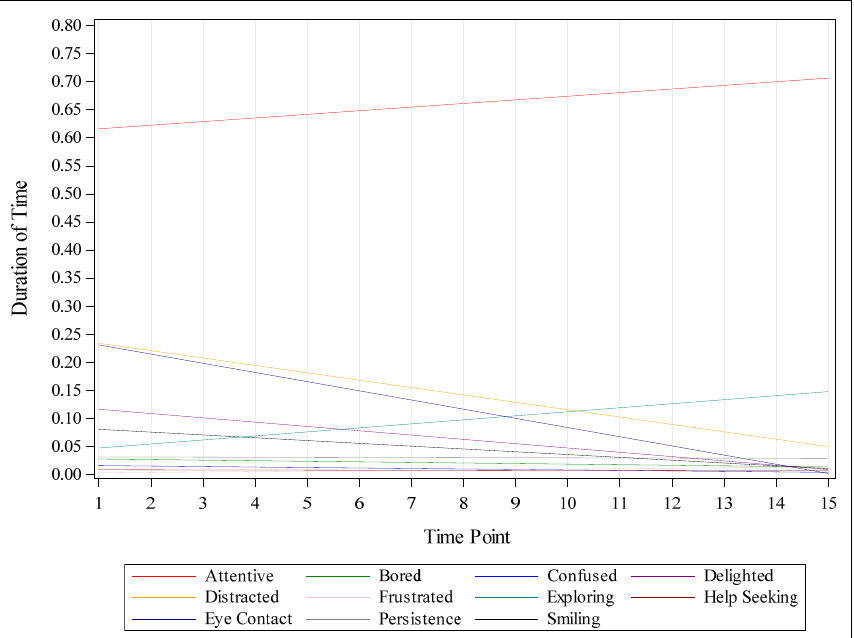
Figure 1. Changes in behavior and affect states over time. Duration of time is measured as the ratio of observed behavior to the recorded footage of each occasion. The frequency of Ryan’s several iPad manipulations and social interactions during our study are presented in Table 3. During the first few sessions in which Ryan was unfamiliar with iPad navigation, he repeatedly chose to play the same app. He randomly